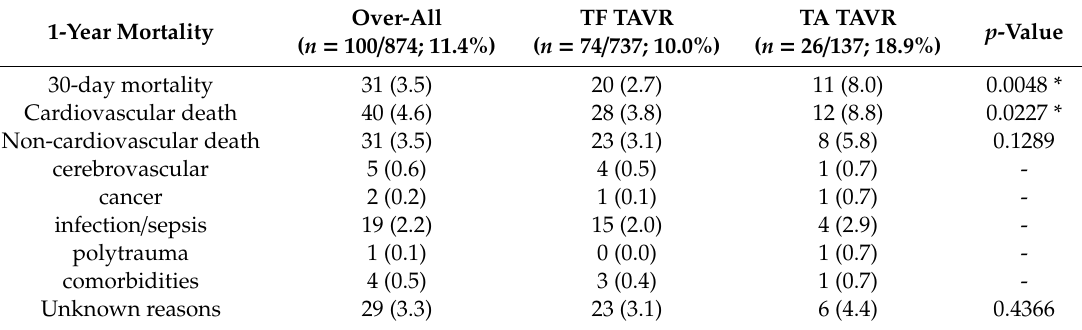
Table A2. 1-year mortality leading to all-cause